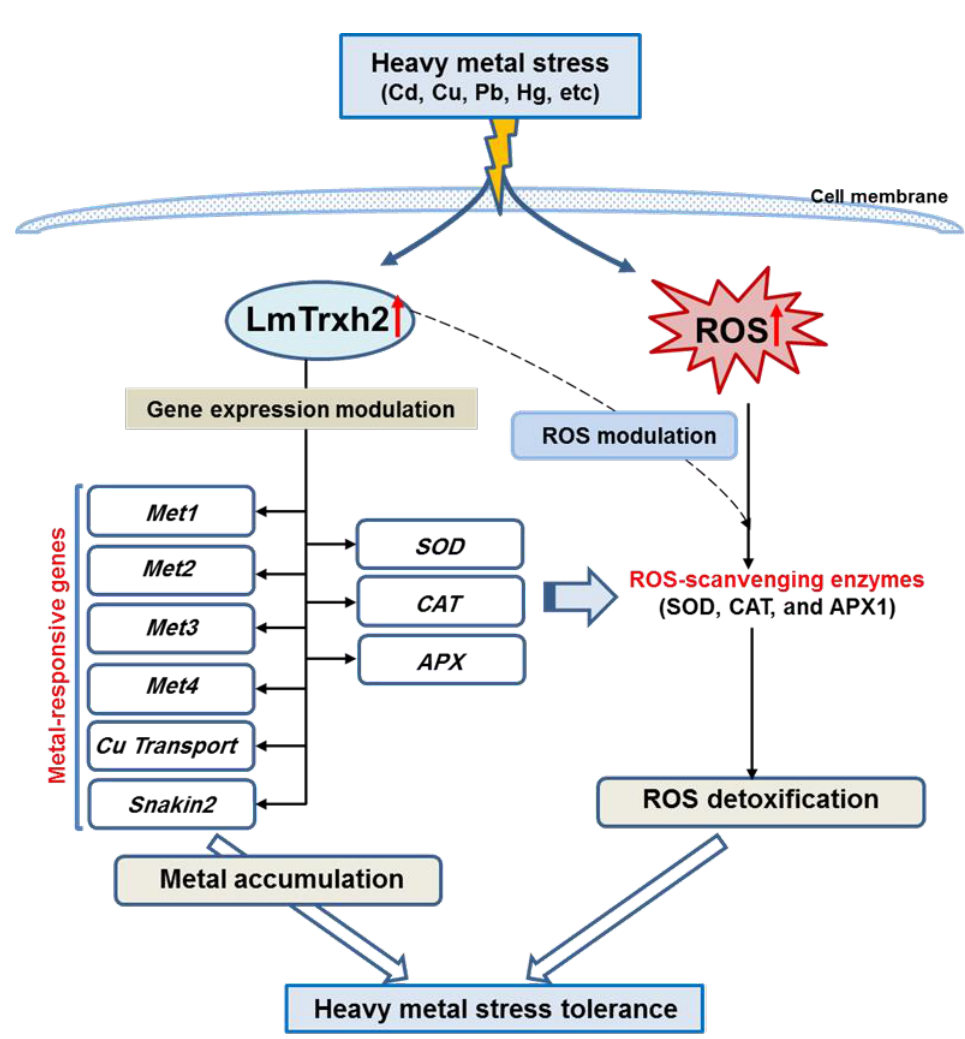
Figure 8. A hypothetical model for LmTrxh2 -mediated heavy metal stress